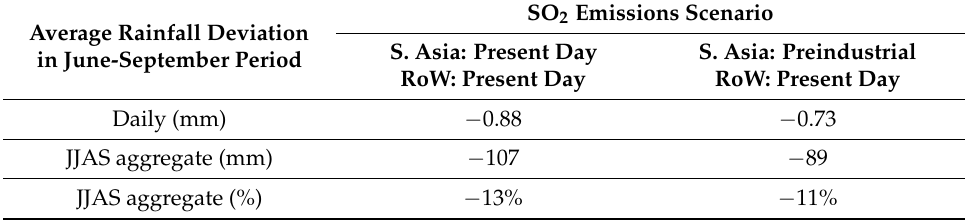
Table 1. Change in daily and seasonal rainfall during the June–September monsoon season calculated for various SO 2 emissions scenarios of South Asia and for the rest of the world (RoW) from Guo et al. [13] (p. 6952). The percentage refers to the JJAS aggregate deviation compared to the seasonal average aggregate rainfall from [15]